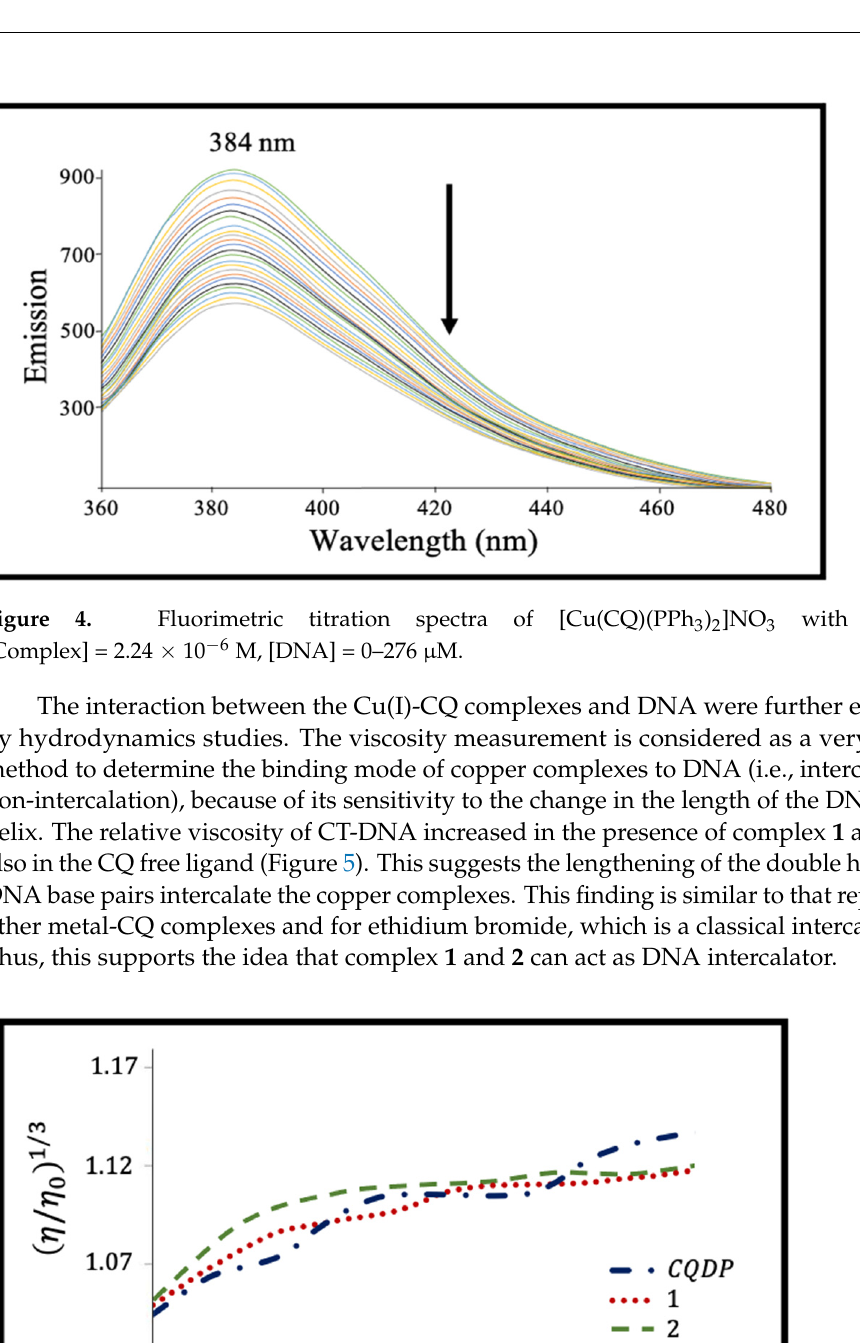
( B ) Figure 3. Spectrophotometric titration spectra of ( A ) [Cu(CQ)(PPh 3 ) 2 ]NO 3 and ( B ) [Cu(CQ) 2 ]Cl with CT-DNA. The intensity of the emission bands of complexes 1 and 2 reduces as the DNA con- centration increases until saturation (see Figure 4 for complex 1 ). This electronic pertur-